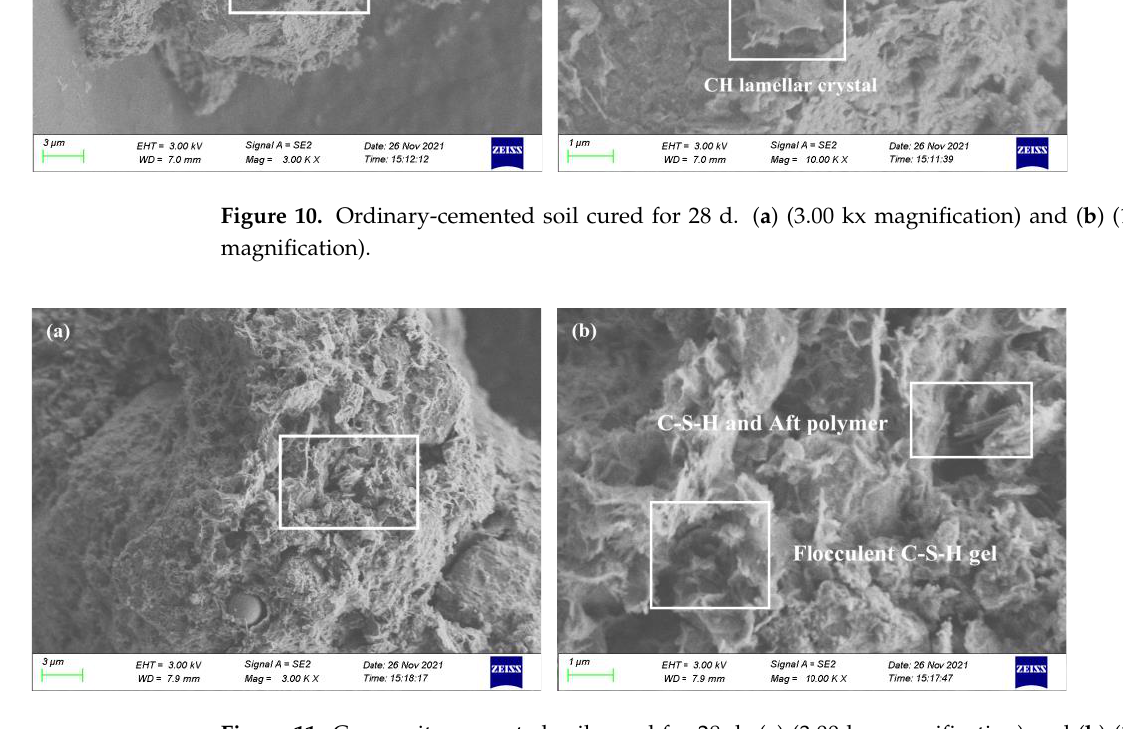
Figure 11. Composite-cemented soil cured for 28 d. ( a ) (3.00 kx magnification) and ( b ) (10.00 kx magnification).